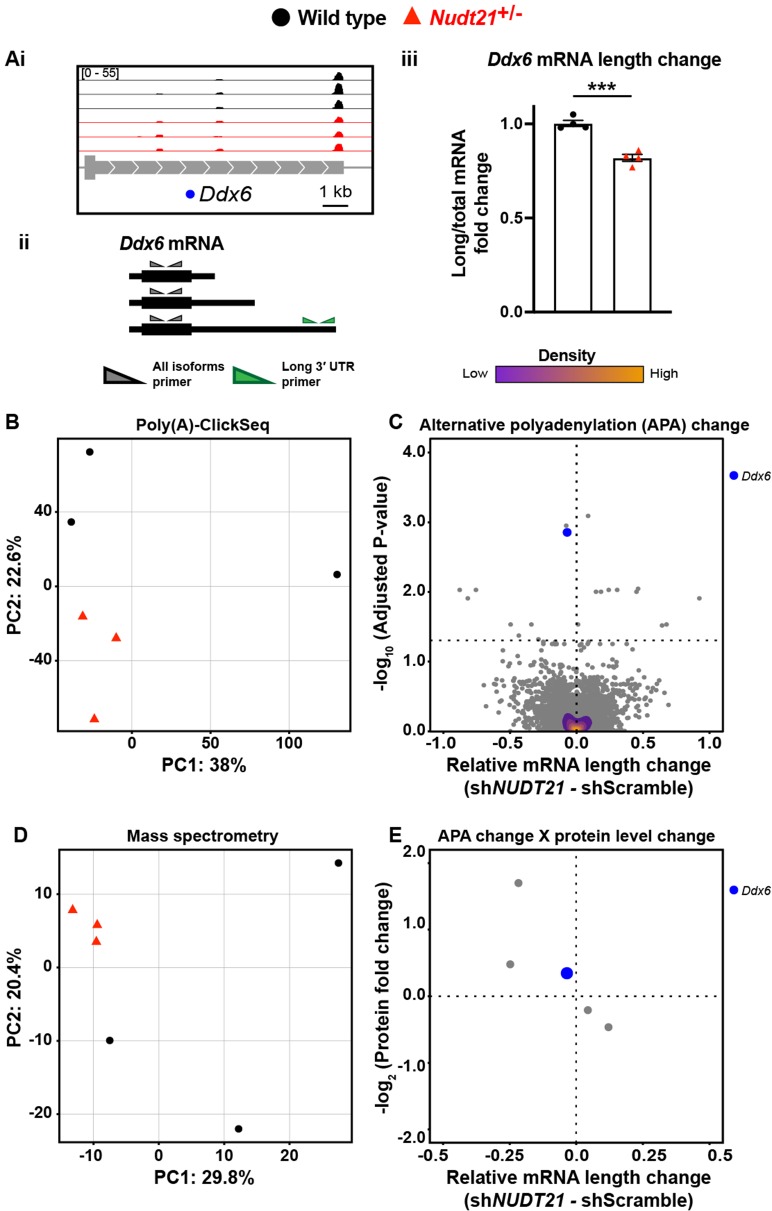
Nudt21 heterozygotes have altered hippocampal alternative polyadenylation.(A)(i) Representative poly(A)-ClickSeq (PAC-seq) track showing altered alternative polyadenylation in Ddx6: n = 3/treatment. Peaks are 3′ end sequencing reads. Each peak indicates a different mRNA isoform with a different cleavage and polyadenylation site. Bracketed numbers show counts per million; kb stands for kilobases. (ii) Schemata of the three Ddx6 mRNA isoforms identified by PAC-seq. Triangles show the binding sites of the qPCR primers used to validate the PAC-seq results. The gray primers detect all the Ddx6 mRNA isoforms, whereas the green primers only detect the isoform with the longest 3′ UTR. (iii) Gapdh-normalized RT-qPCR quantification showing relatively less of the long isoform of Ddx6 in the hippocampi of 46-week-old Nudt21+/- mice compared to their wild-type littermates. Error bars indicate SEM. Data analyzed by unpaired, two-tailed t-test. p=0.0003. (B) Nudt21+/- and wild-type mice separate by principle component analysis (PCA) of poly(A) site usage. (C) Volcano plot showing relative mRNA length change in Nudt21+/- mice compared to their wild-type littermates. The horizontal, dashed line shows Padjusted = 0.05, n = 3/genotype. (D) Nudt21+/- and wild-type mice segregate by PCA of the proteome by quantitative mass spectrometry. (E) Mass spectrometry quantification of protein level fold change for genes with significantly altered APA (Padjusted <0.05). Source files for the PAC-seq and mass spectrometry quantification data are available in Figure 4—source data 1. ***p<0.001.Figure 4—source data 1.RNA length and protein level changes in genes with misregulated APA in Nudt21+/-mice.Alternative polyadenylation (APA), likelihood ratio (lr), degrees of freedom (df), mass spectrometry (MS), fold change (FC).